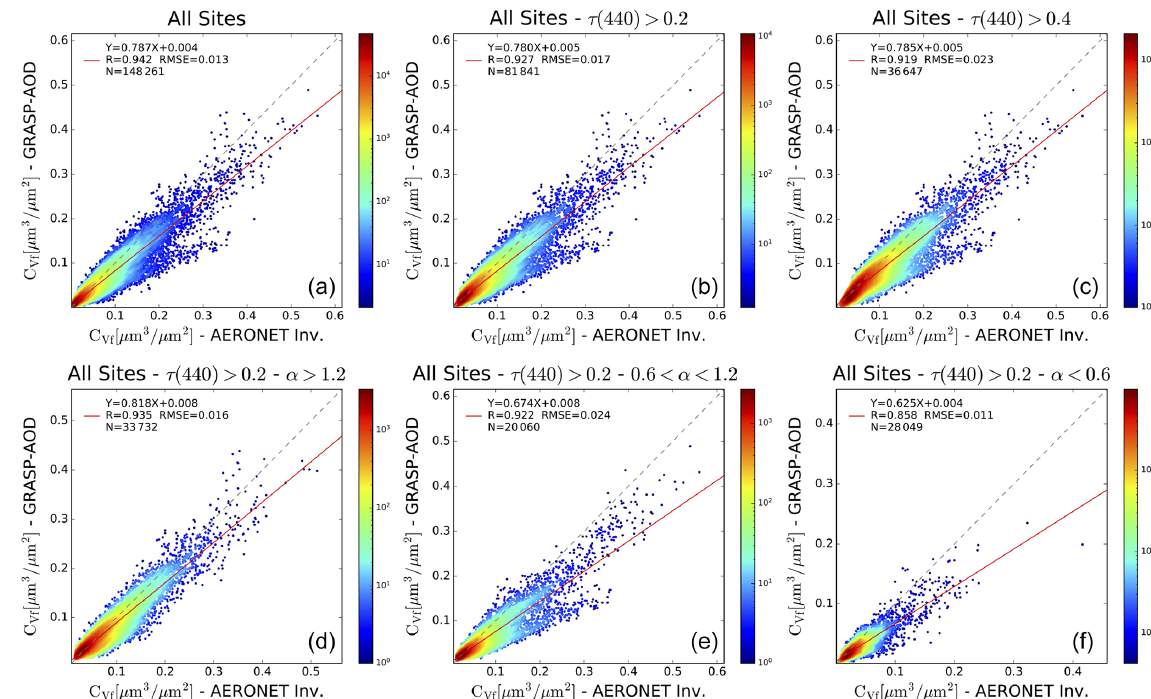
Figure 8. Comparisons between the fine-mode volume concentration ( C Vf [µm 3 /µm 2 ]) obtained by the GRASP-AOD and AERONET aerosol retrieval algorithm for all sites considered in the analysis (Table 1) for the period 1997–2016 using different thresholds for τ( 440 ) and Ångström exponent values. Panels (a) – (c) analyze the effect of different lower limits of τ( 440 ) (from left to right): all retrievals ( τ( 440 ) > 0 . 02), retrievals with τ( 440 ) > 0 . 2, and retrievals with τ( 440 ) > 0 . 4. Panels (d) – (f) analyze the results for the retrievals with τ( 440 ) > 0 . 2 and for different ranges of Ångström exponent from (d) to (f) : retrievals with α > 1.2, retrievals with α between 0.6 and 1.2 and, finally, retrievals with α < 0 . 6. Color bars represent data density in a 0 . 01 × 0 . 01µm 3 /µm 2 grid. A logarithmic scale has been chosen given the strong data density at low